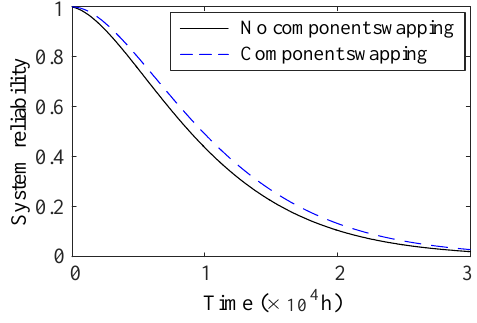
Figure 10. System reliability with all possible swapping.